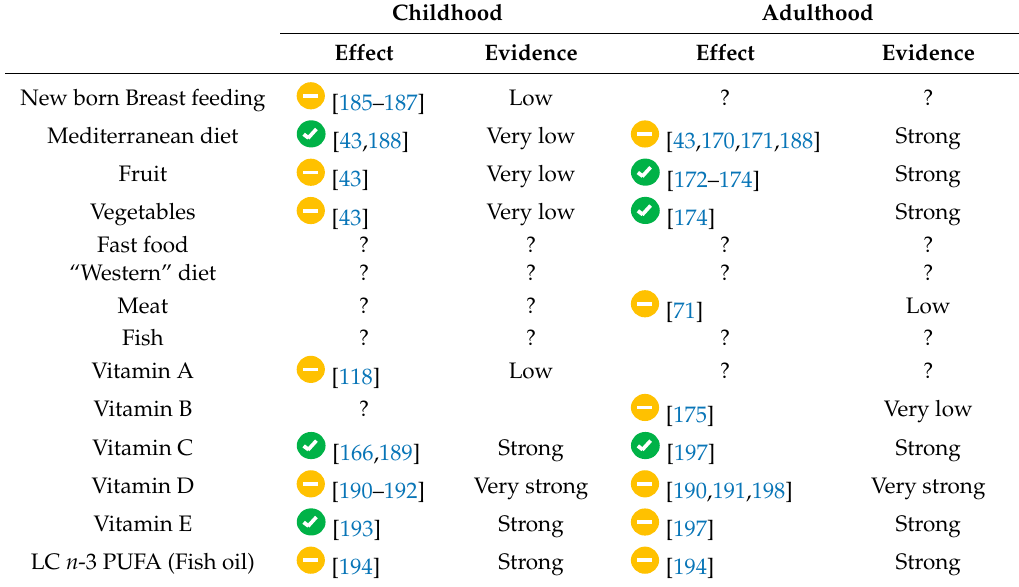
Table 1. Diet and risk of asthma or wheezing. Beneficial effect; negative effect; No